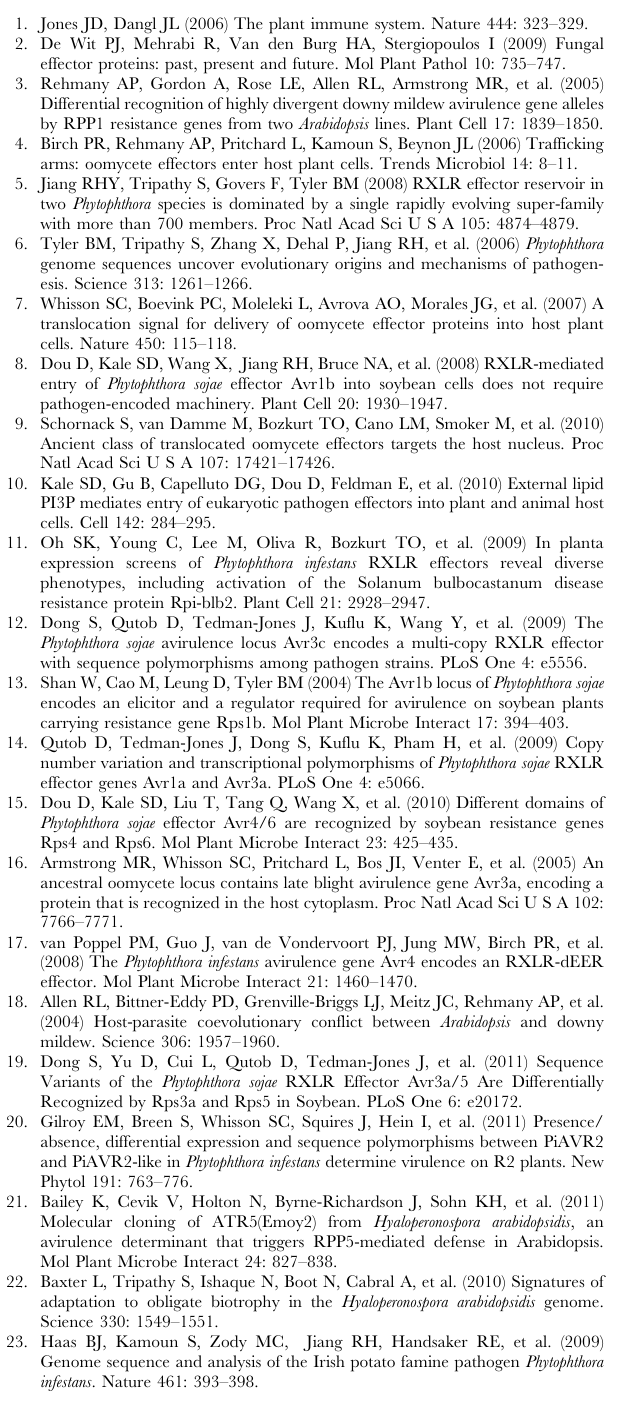
Table S8 Primers used in this